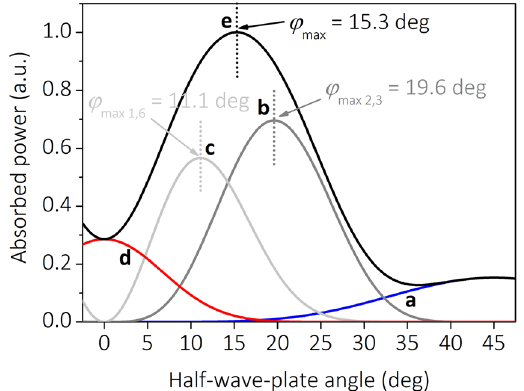
Figure 3. Absorbed laser power versus HWP orientation angle. The calculated absorbed laser power per unit volume versus HWP orientation angle: ( a ) 1 st term in Equation (1); ( b ) 2 nd term in Equation (1); ( c ) 3 rd term in Equation (1); ( d ) 4 th term in Equation (1); ( e ) the total absorbed power per unit volume calculated by using entire Equation